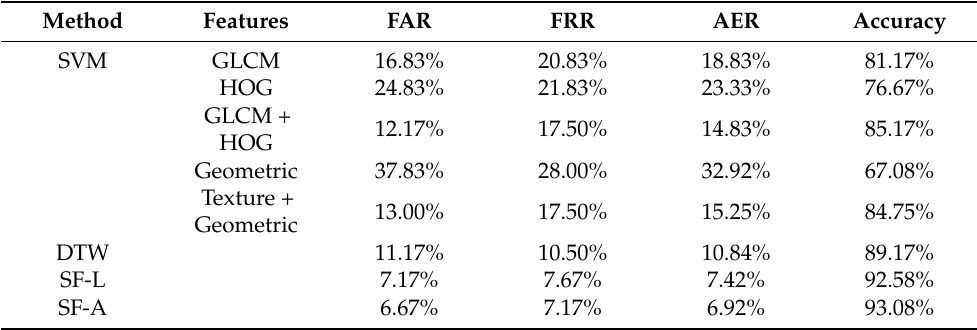
Table 4. The result of three training samples.